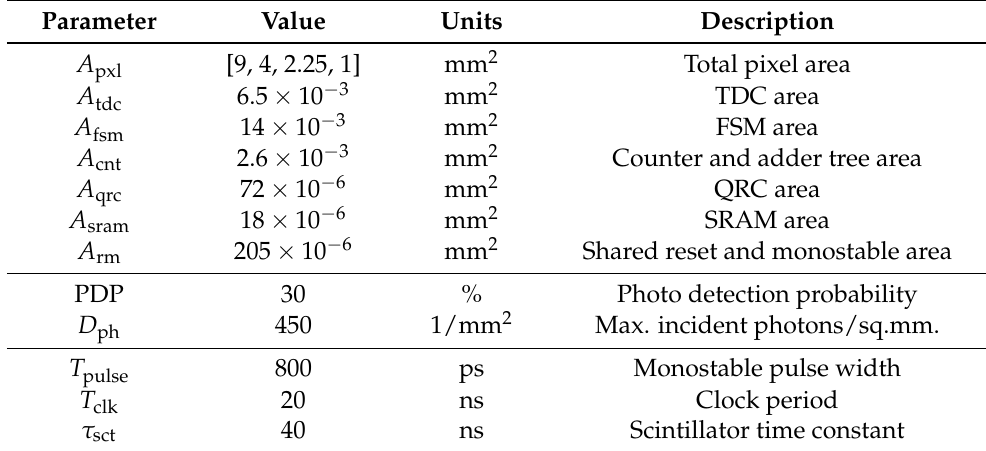
Table 1. Parameter values used for the architectural exploration. The data were obtained from the implemented digital SiPM and its experimental characterization.